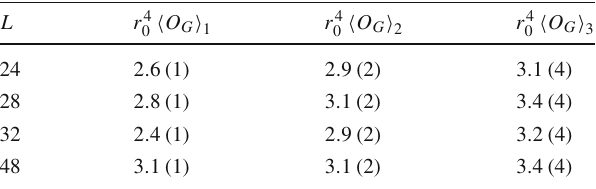
Table 6 Determination of the gluon condensate at different volumes. Thedeterminationlabelledwith1isobtainedfromtheweightedaverage ofthevaluesatthethreelargestvaluesof β .Thedeterminationslabelled with 2 and 3 are obtained by studying the scaling of a 4 (cid:3) O G (cid:4) with a 4 , as in the right panel of Fig. 14; they correspond respectively to the fit without and with a 6 correction (see text for the details)